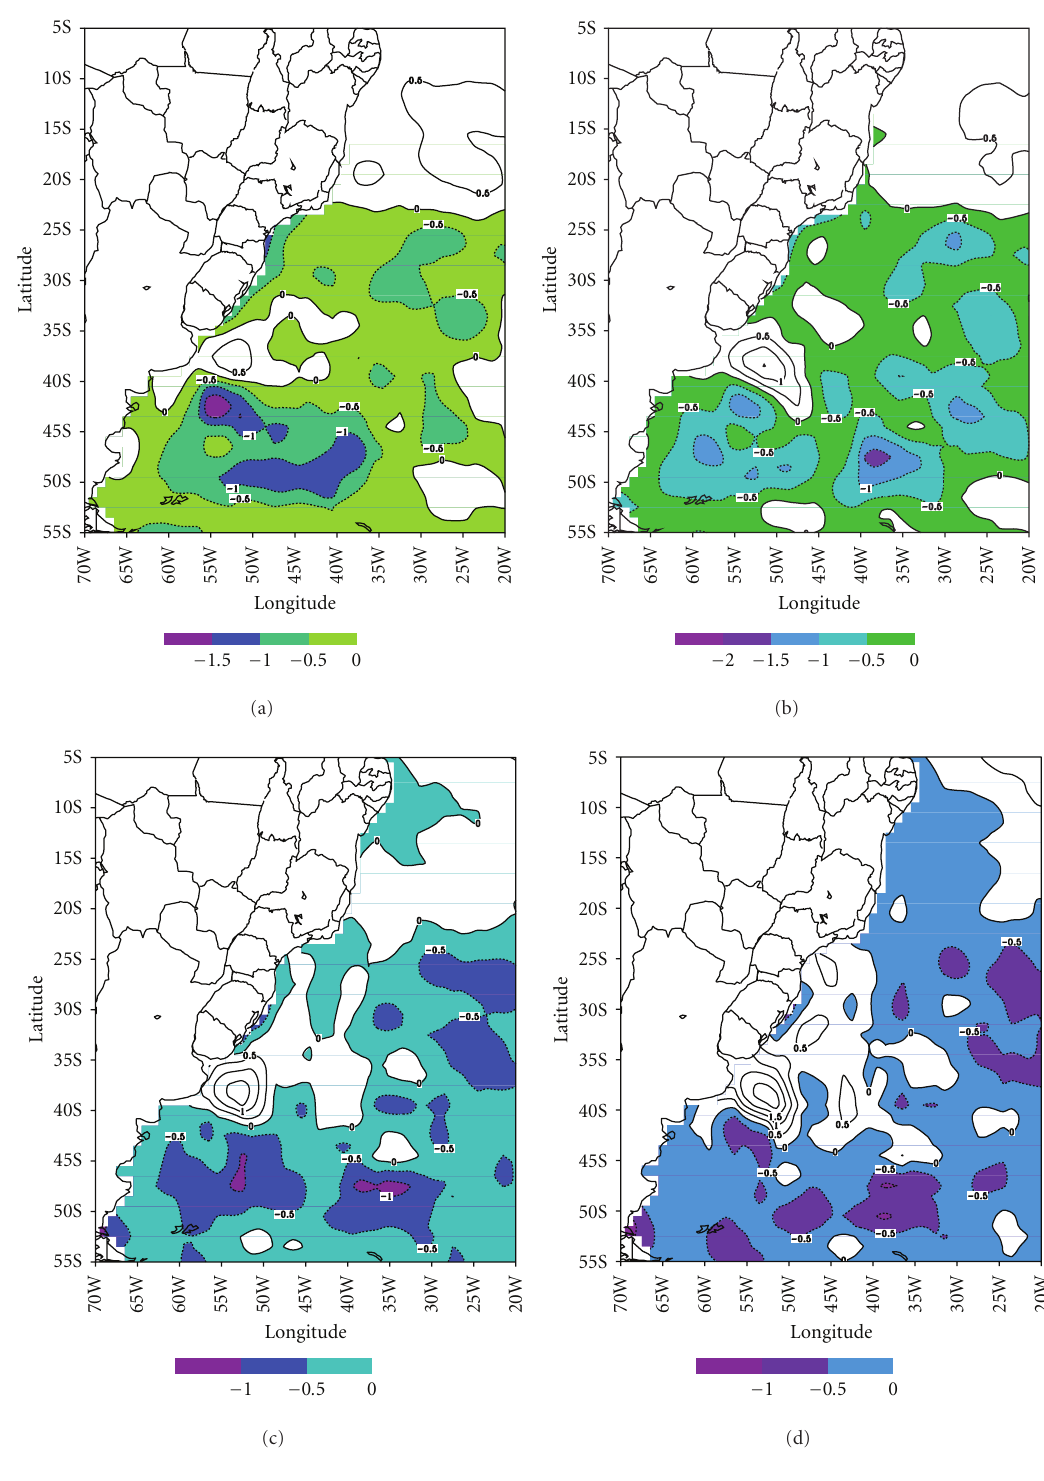
Figure 2: SST anomaly from NOAA-OI for 2008 relative to the mean from 1982 to 2008 for (a) April, (b) May, (c) June, and (d) July (source: